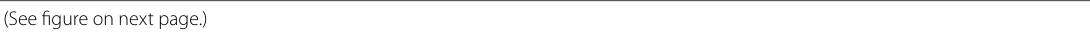
Fig. 4 Validation of the Ghd8 effect on mid-parent heterosis (MPH) using near-isogenic lines (NILs) and complementation transgenic lines. a Graphical genotype of NIL- Ghd8 NIP showing a single introduced Nipponbare segment encompassing Ghd8 in the ZS97 background. b The heterosis advantage of Ghd8 for the yield traits in hybrids of NIL- Ghd8 NIP and NIL- Ghd8 ZS97 in a two-year trial. Error bar represents the mean (n 3). c The dominance degree of Ghd8 effect on spikelet number (SN) and grain yield per plant (YD) in hybrids. If the effect has an excessive = degree of dominance, it is set to a score of 5.0. d Phenotypes of the complementation transgenic lines and their hybrids at maturity. Ghd8 + , homozygous-positive transgenic line containing the alleles Ghd8 NIP ; Ghd8 − , homozygous-negative control lines; F 1 denotes the hybrid derived from the cross of the independent complementation transgenic plant and corresponding negative plant. Scale bars, 10 cm. e , f MPH of Ghd8 for SN (E) and YD (F) in the F 1 hybrids across a two-year trial. The error bar represents the mean